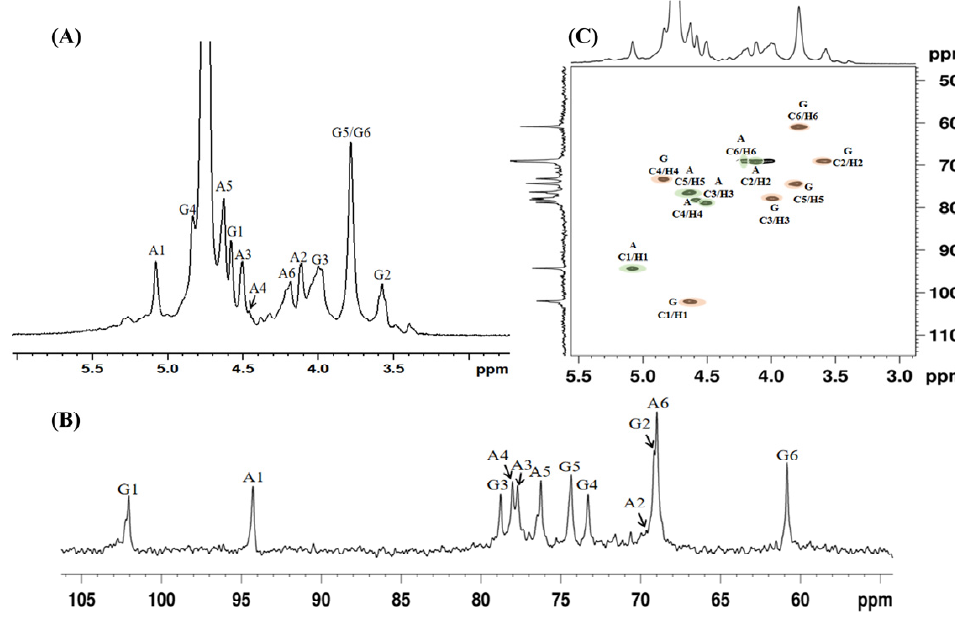
Figure 5. ( A ) 1 H NMR, ( B ) 13 C NMR, and ( C ) HSQC spectra of DC-6. Correlation peaks are marked on the spectrum: G4S (G)—orange and AnGal (A)—green.